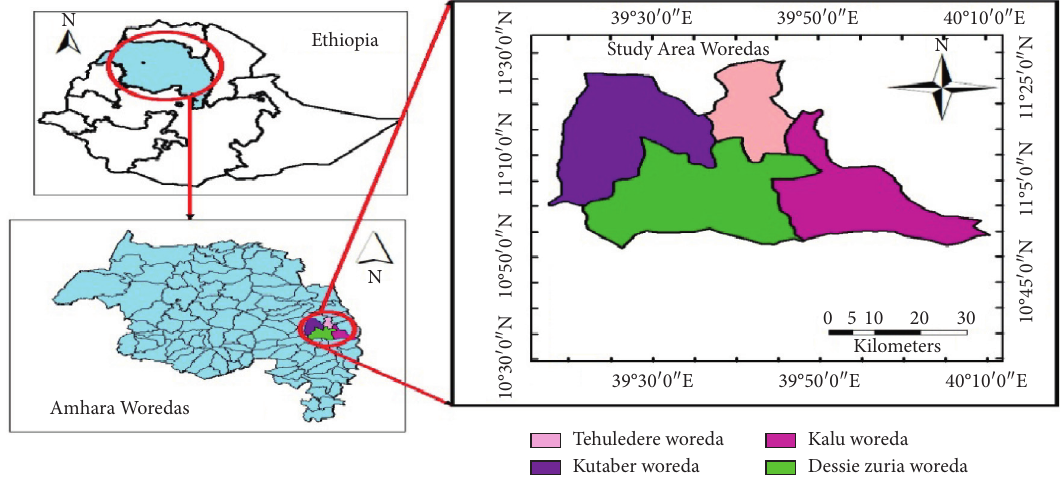
Figure 1: Map of the study area (using Garmin GPS